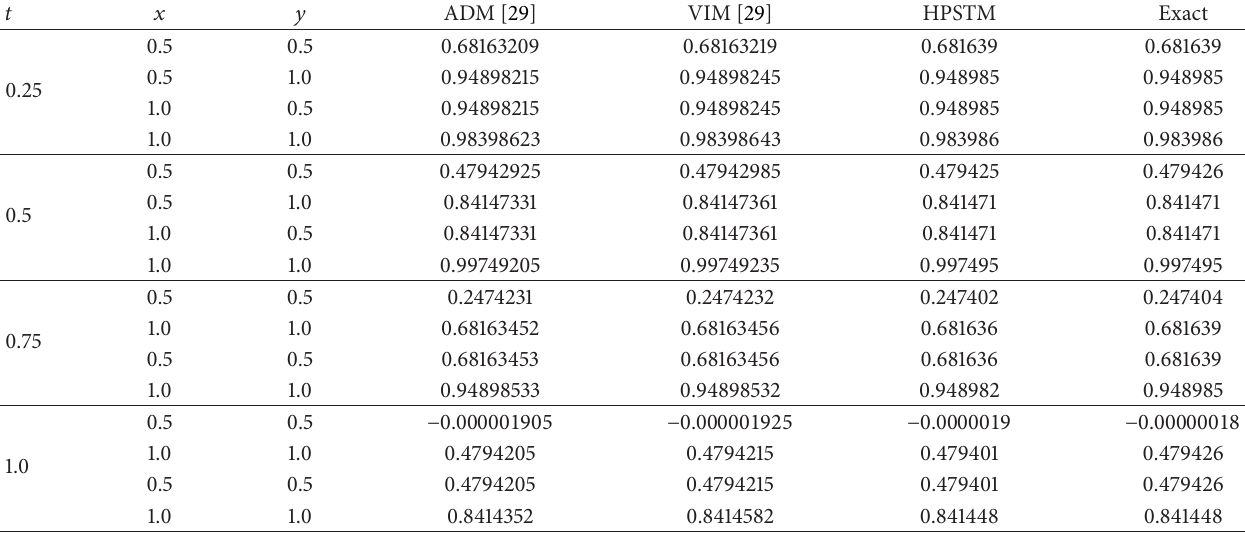
Table 1: Numerical values for approximate solutions of (49) via ADM, VIM, and